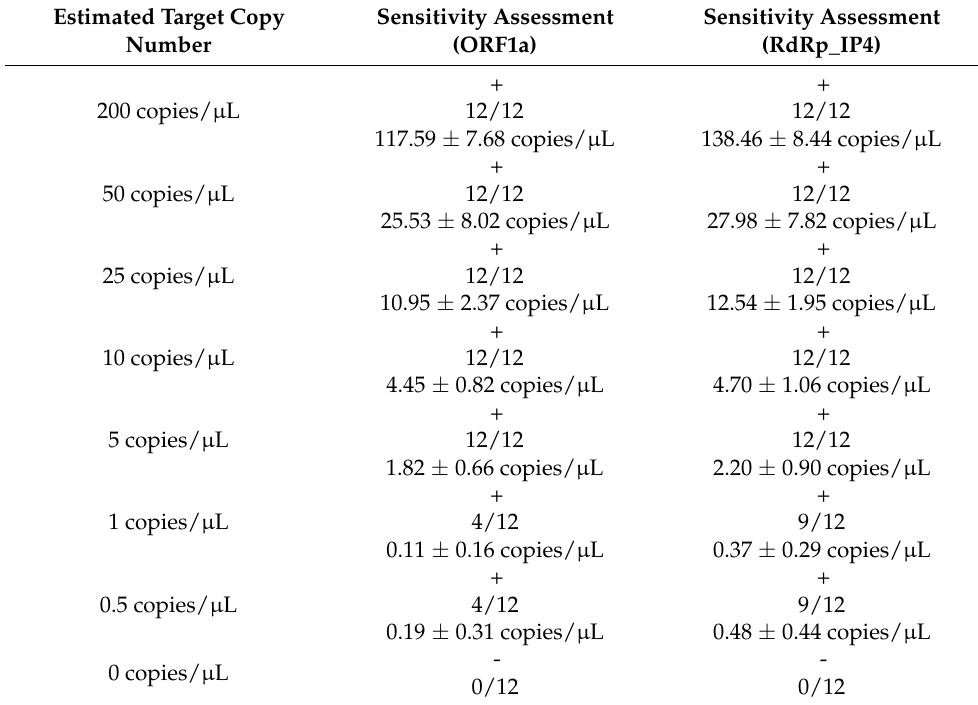
Table 4. Sensitivity assessments of the developed RT-ddPCR